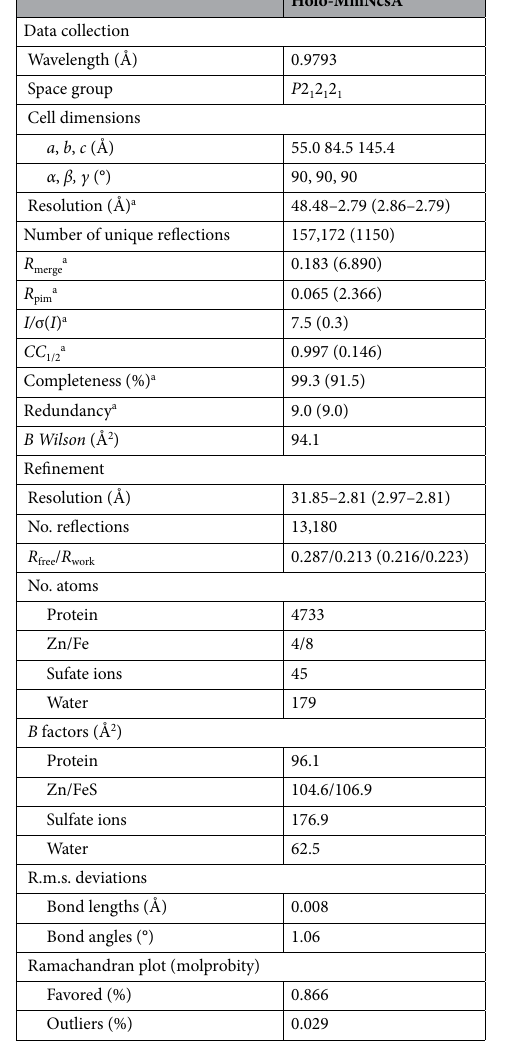
Table 1. Data collection and refinement statistics. a Values in parentheses are for highest-resolution